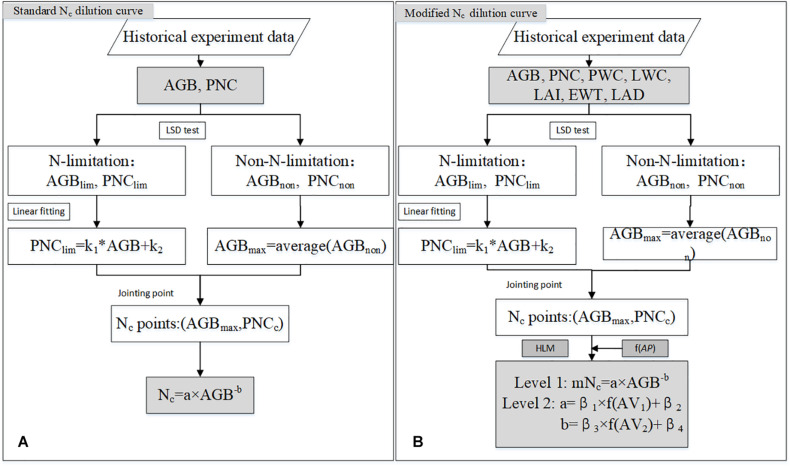
Flow chart for standard Nc dilution model (A) and the mNc dilution model (B). AGBlim and PNClim represent AGB and PNC corresponding to N limitation plots, respectively. AGBnon and PNCnon represent AGB and PNC corresponding to non-N -limitation plots, respectively. The k1 and k2 were parameters obtained by calibrating PNClim with AGBlim.